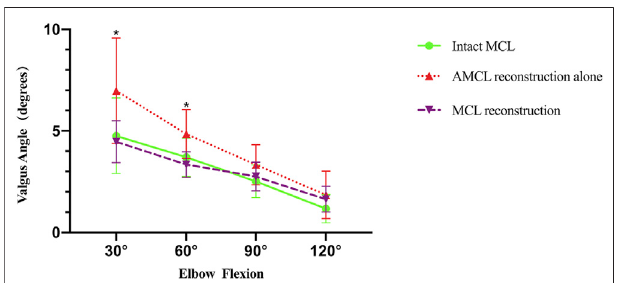
FIGURE 3 | Line graph showing valgus angle applied 2 Nm torque at different elbow fl exion angles for intact MCL, AMCL reconstruction alone, MCL reconstruction. Error bars indicate standard deviation. * p <